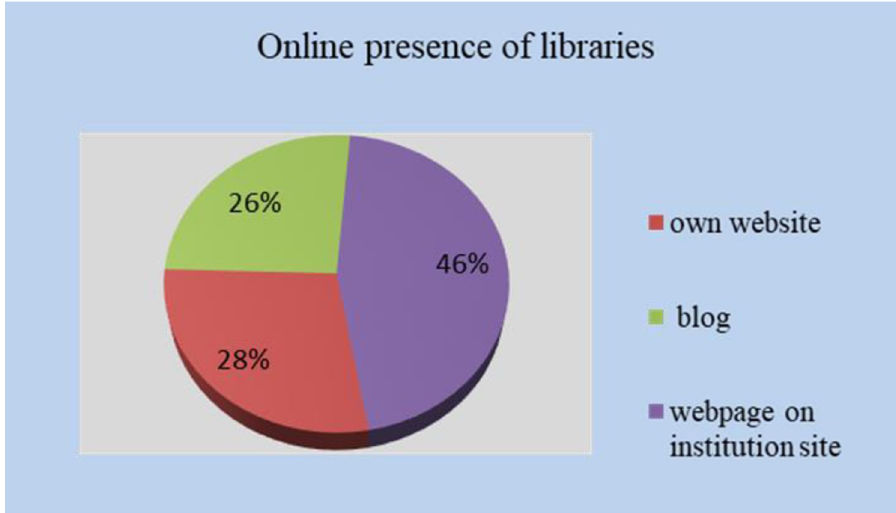
Fig 5. Online presence of Romanian